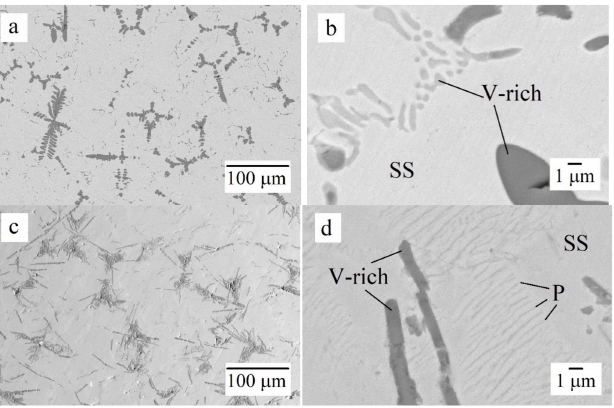
Figure 3. SEM microstructure of the Al 0.25 CoCrFeNiV alloy without EMP ( a , b ), and after EMP ( c , d